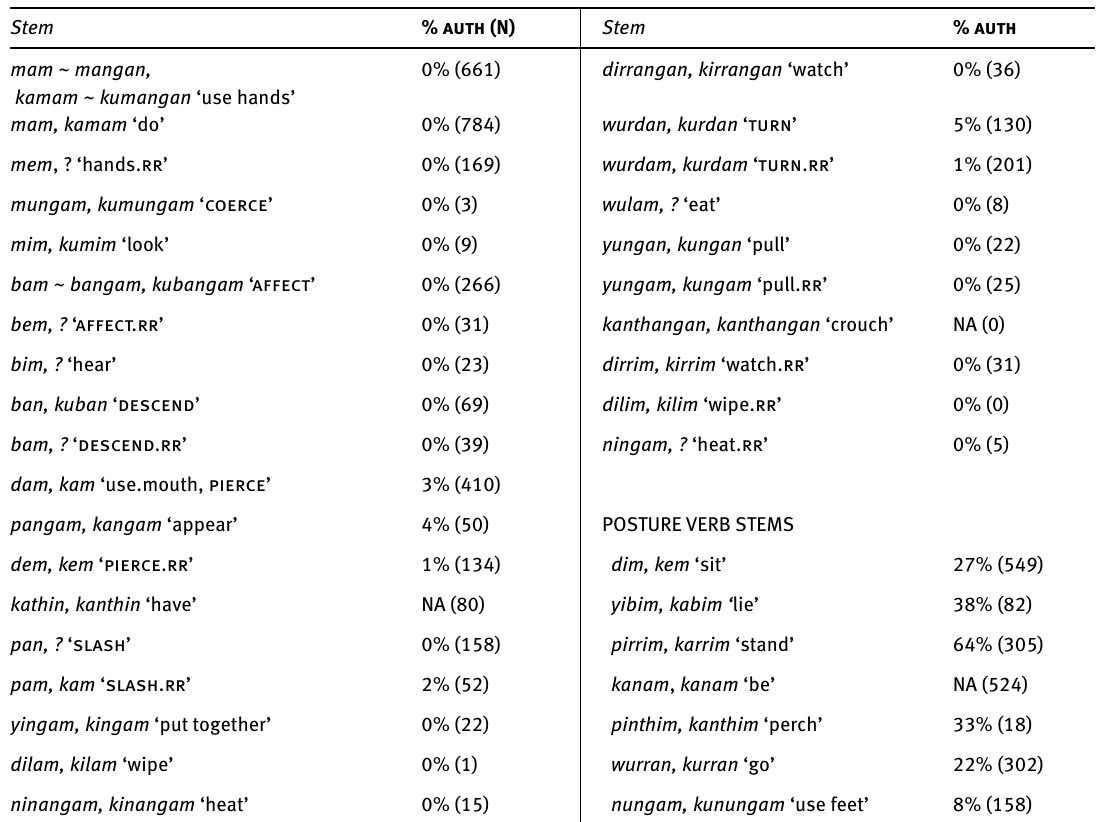
Table 2. Corpus percentage of 3.nfut verb stems with auth marking. Each stem is illustrated in 3sg.nfut, 3sg.auth forms. Question marks appear where auth is unattested. Stems glossed in small caps are semantically bleached, and their glosses are largely conventional (Mansfield,